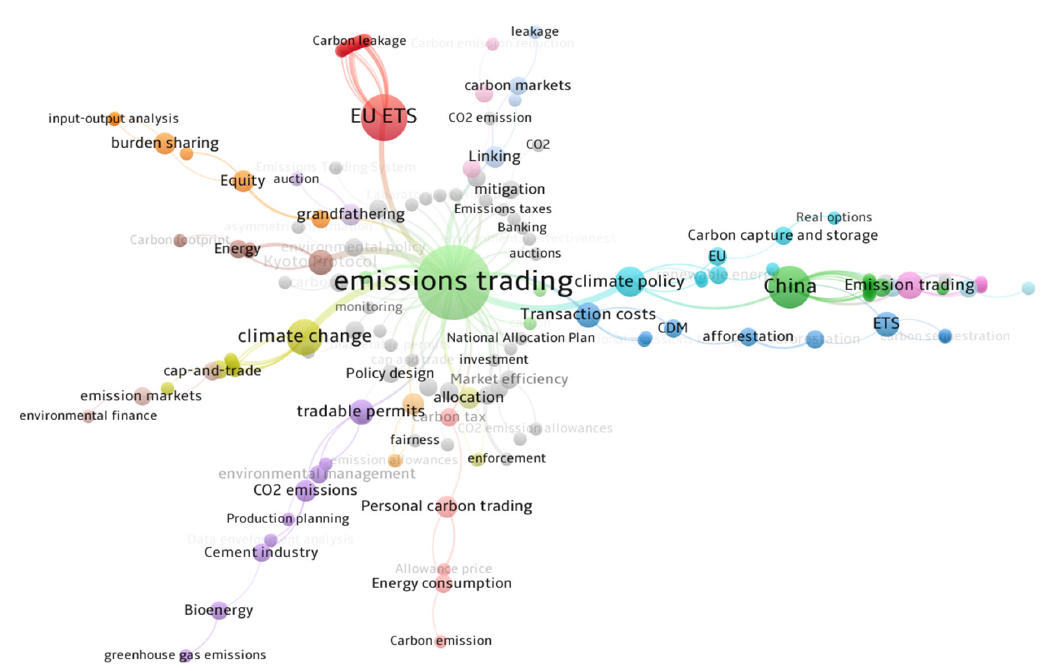
Figure 1. The frequency of keywords: research hotspots.